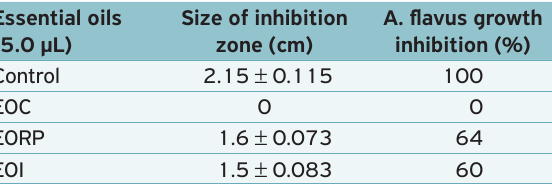
Table 3. Essential oils of leaves of A. conyzoides collected in Campinas, Ribeirão Pires and Ibiúna, size of inhibition zone, and A. flavus growth